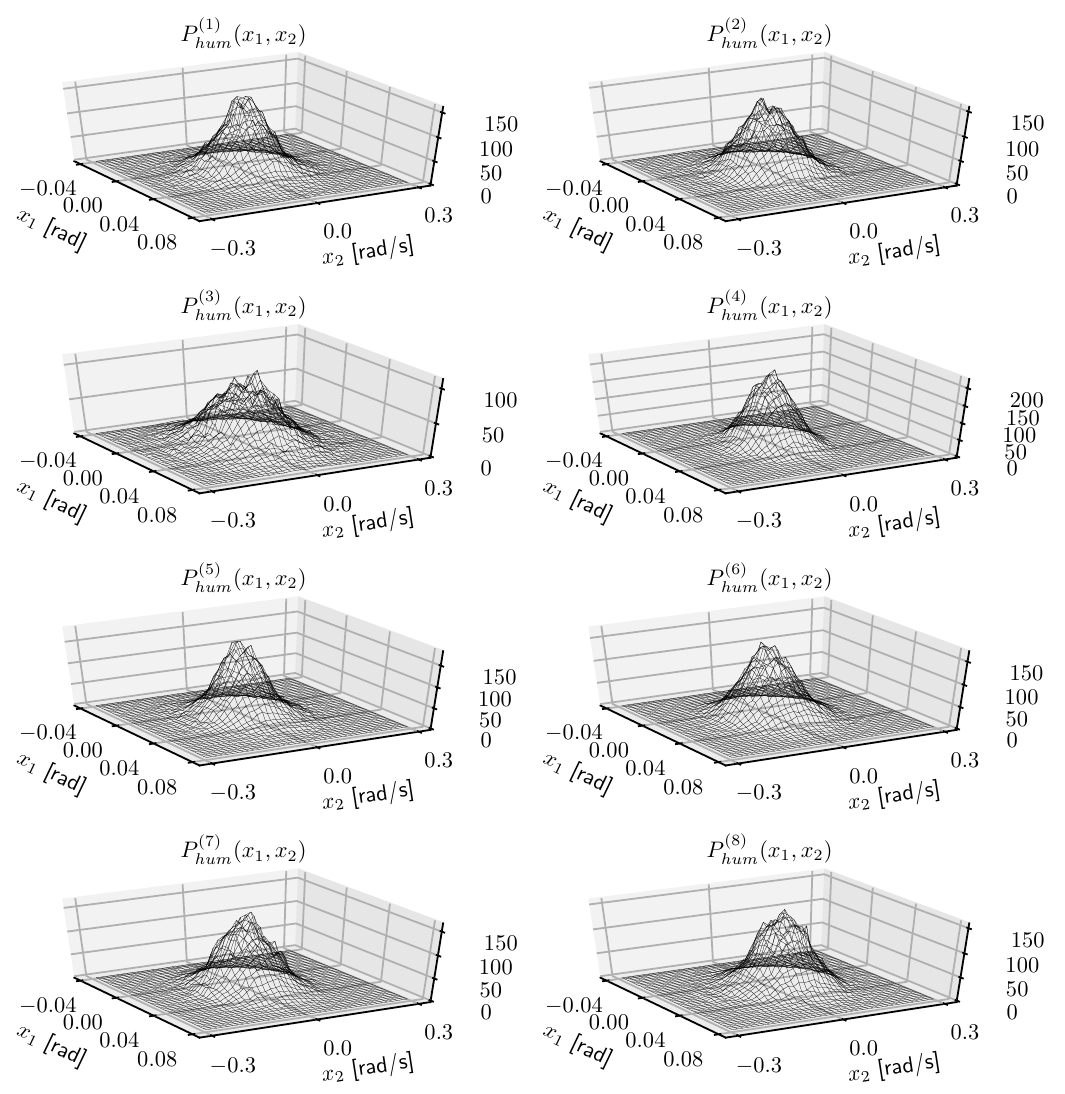
Figure 4. The measured joint probability density functions (PDFs) from all participants ( s = 1,